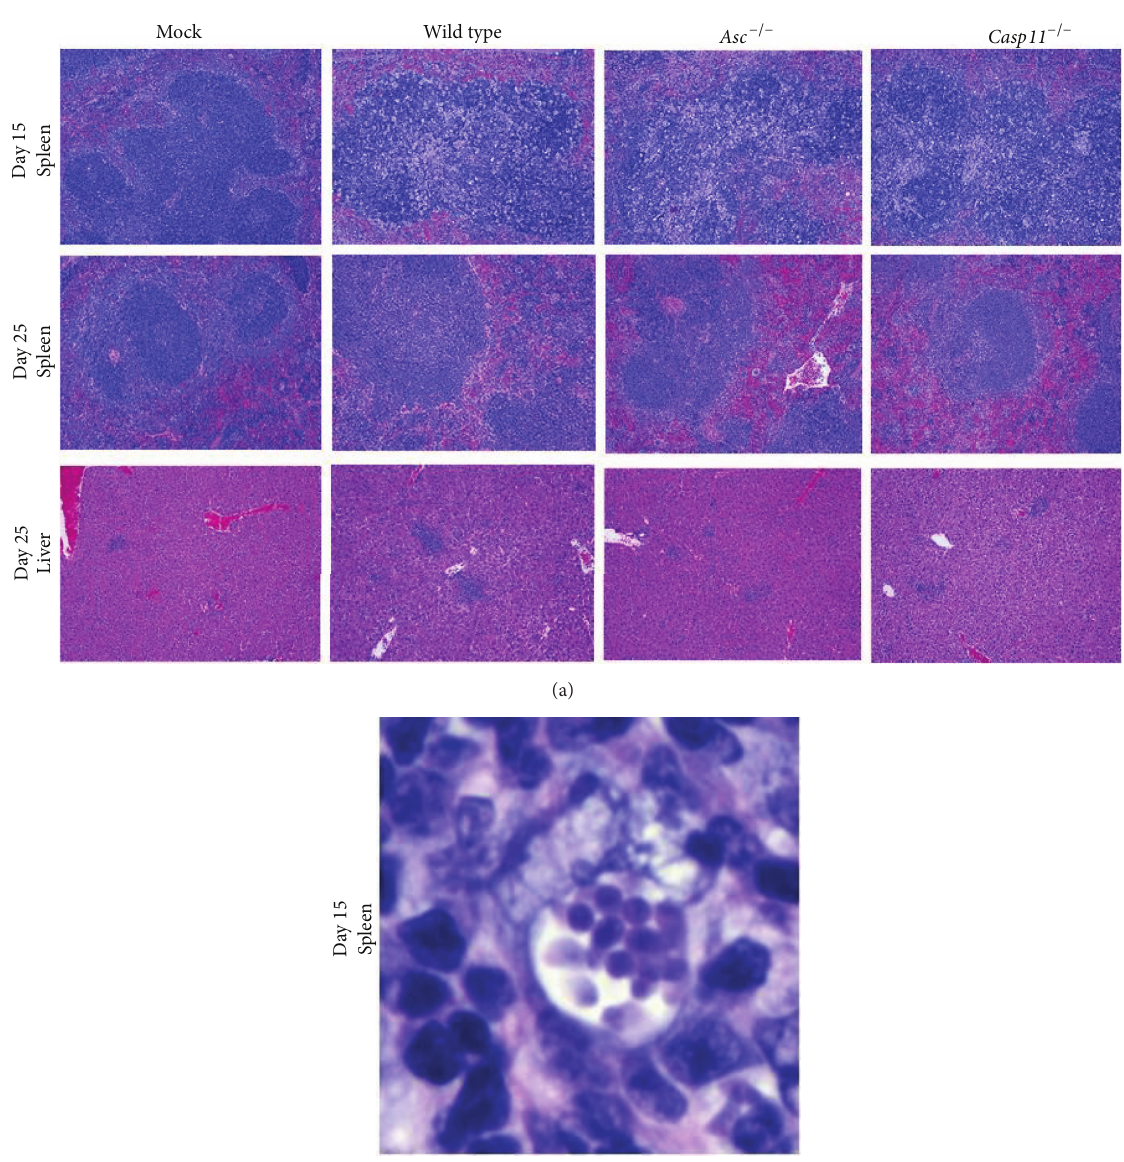
Figure 3: Toxoplasma gondii tachyzoites induced severe toxoplasmosis which resolved during the chronic phase of disease in all surviving animals. Wild type, Casp11 −/− , and Asc −/− mice were infected with 1,000 Toxoplasma gondii Me49 tachyzoites via i.p. administration and necropsied at 15 and 25 days after inoculation (d.p.i.). (a) Tachyzoite injection resulted in significantly increased spleen histopathology